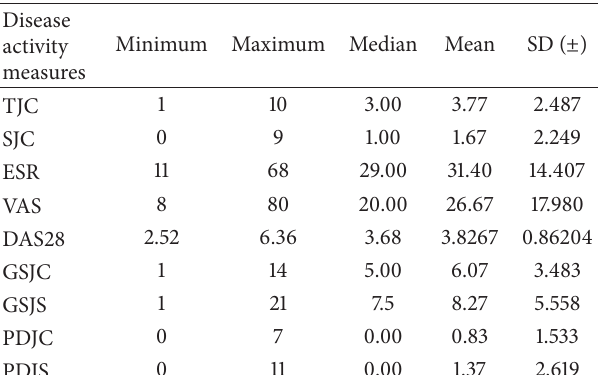
(Figure 10) and GSJS ( 𝜌 : 0.434; 𝑃 : 0.017) and not with